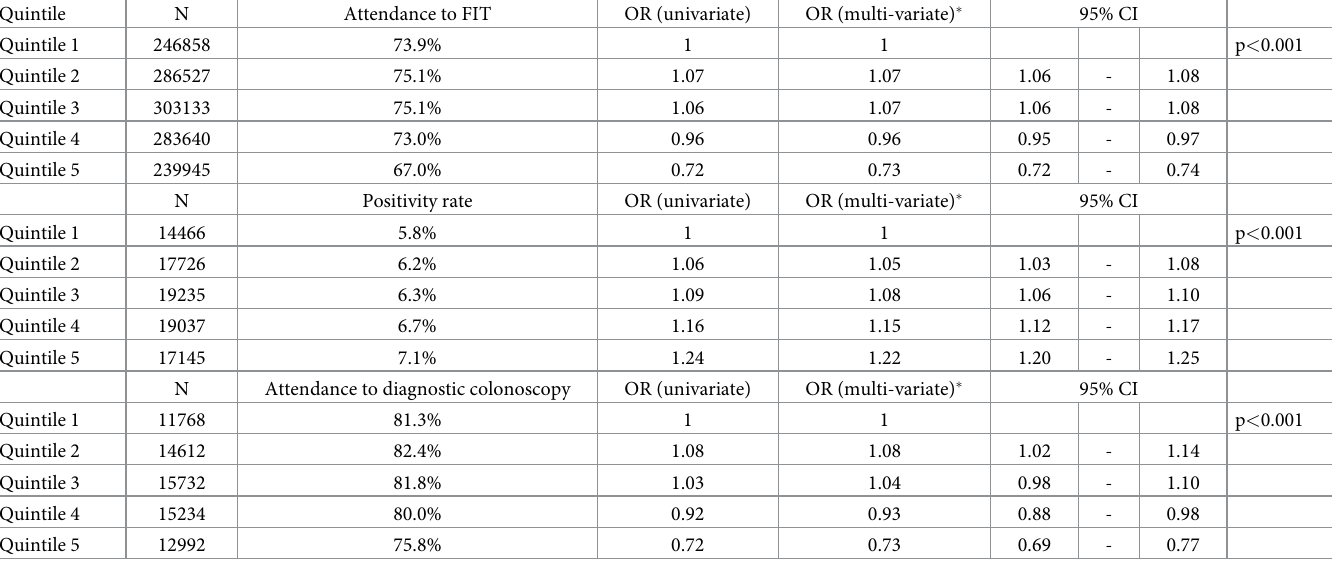
Table 2. The participation to FIT, positivity rate and colonoscopy uptake after a positive FIT in each quintile, with the univariate and multivariate odds ratio (OR) and 95% CI.